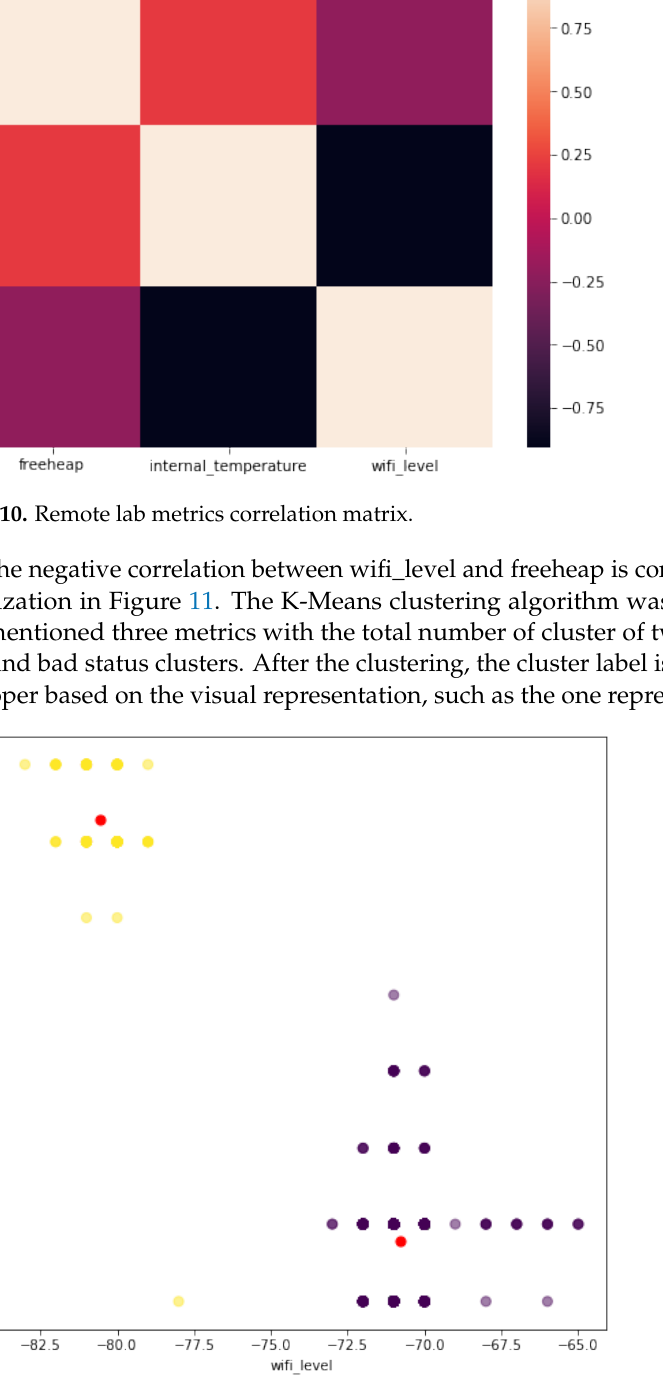
Figure 11. Remote lab K-Means clusters. Red dots are the centroids of each cluster, cluster 0 has yellow dots and cluster 1 has purple